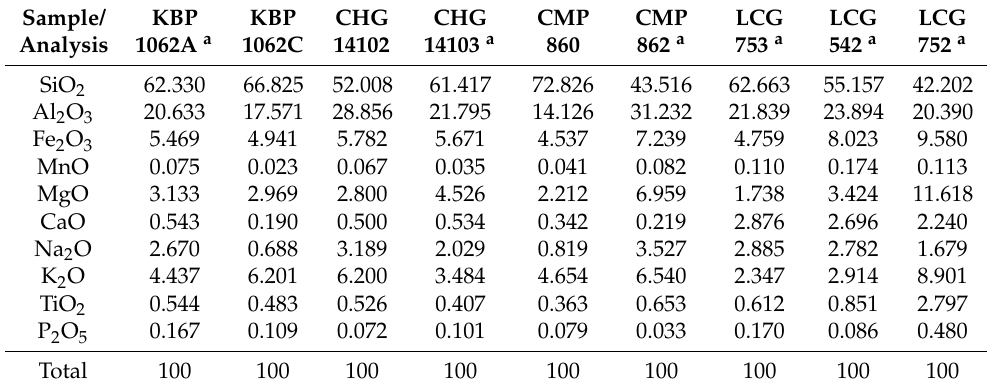
Total 100 100 100 100 100 100